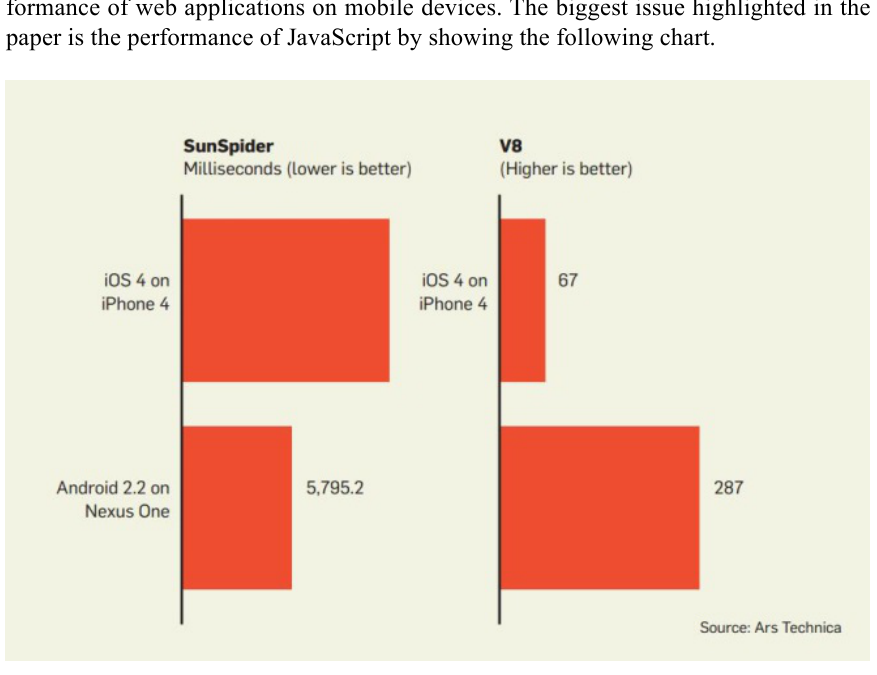
Fig. 1. Performance of JavaScript on an Android 2.2 device and an iOS 4